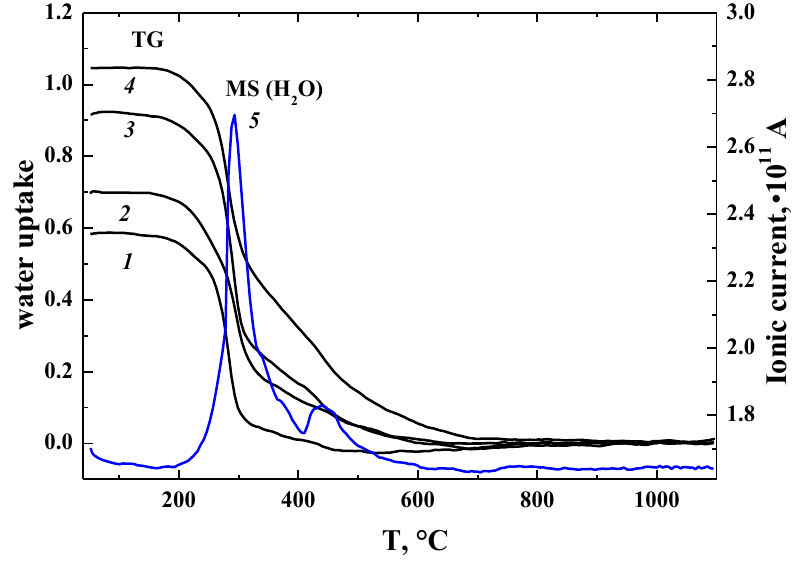
Figure 2. TG data for hydrated samples BaLaInO 4 ∙ n H 2 O ( 1 ), BaLa 0.9 Ca 0.1 InO 3.95 ∙ n H 2 O ( 2 ), Figure 3 represents the comparison of TG-curves, DSC-curves, and MS-curves for the hydrated sample BaLaInO 4 · n H 2 O. As can be seen, the sample underwent a mass decrease in the temperature ◦ from 200 to 800 C, which was accompanied by a three endothermic DSC-signals (two well pronounced ◦ ◦ ◦ and one weak signal) at ~320 C, ~500 C, and ~700 C. The MS analysis indicated that the mass change can be attributed by the water loss. No other volatile components (CO 2 , O 2 ) were detected. The